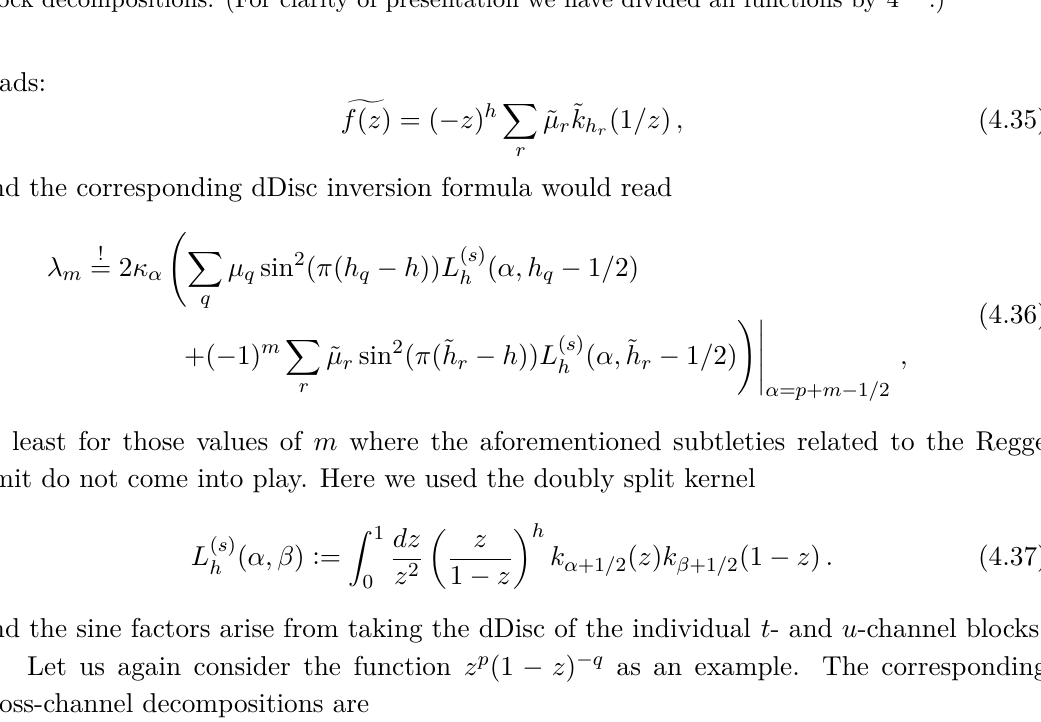
Figure 5 . Convergence of the t -channel block decomposition in the ‘dDisc inversion formula’ (4.36) for z p (1 − z ) − q with p = 0 . 2 , q = 0 . 3 and h = 0 . 7 . We plot ˇ f ( t ) ( α ) + ˇ f ( u ) ( α ) on the left and ˇ f ( t ) ( α ) − ˇ f ( u ) ( α ) on the right. The dotted lines correspond to the exact expression, and the red dots are the λ m for α = p + m − 1 / 2 . The solid lines correspond to approximations where we keep only 2 (blue, behind orange), 5 (orange) and 8 (green) terms in each of the cross-channel conformal block decompositions. (For clarity of presentation we have divided all functions by 4 − α